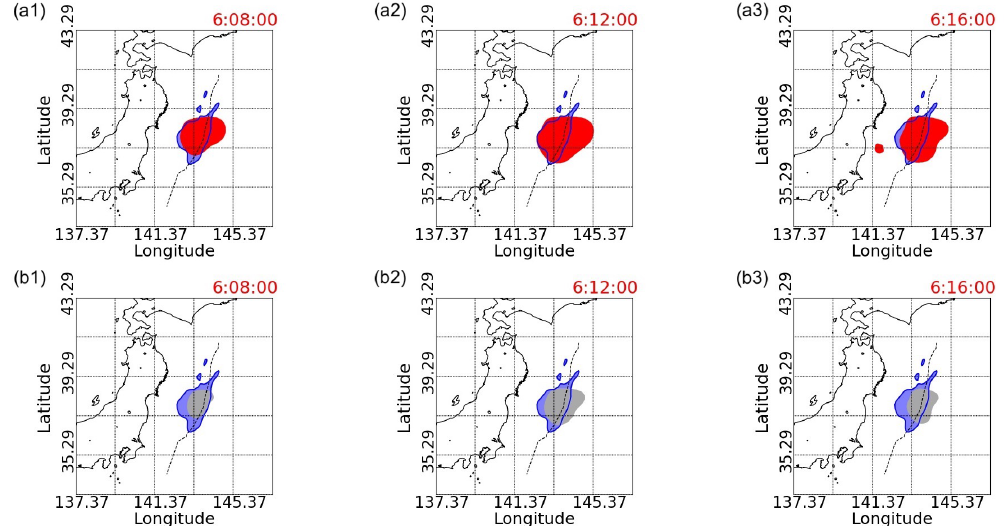
Figure 10. The initial tsunami and TIHs with TEC values less than − 3 or − 4. The blue area is the simulated initial tsunami by inversion analysis with 130 small basis functions implemented by T. Saito et al. (2011). In panels (a1–a3) , the red areas are TIHs with TEC less than − 3, while the dark grey areas in panels (b1–b3) illustrate TIHs with TEC less than − 4. Panels (a1) and (b1) are snapshots at 06:08:00 (UTC); panels (a2) and (b2) are at 06:12:00 (UTC); and panels (a3) and (b3) are at 06:16:00 (UTC). The black dashed line indicates the location of the axis of the Japan Trench.